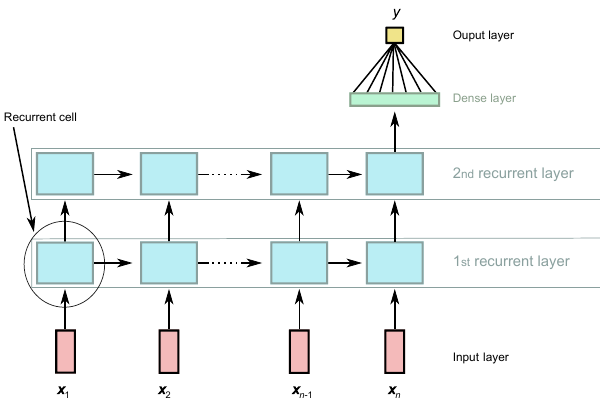
Figure 1. A general example of a two-layer recurrent neural net- work unrolled over time. The outputs from the last recurrent layer (second layer in this example) and the last time step ( x n ) are fed into a dense layer to calculate the final prediction ( y